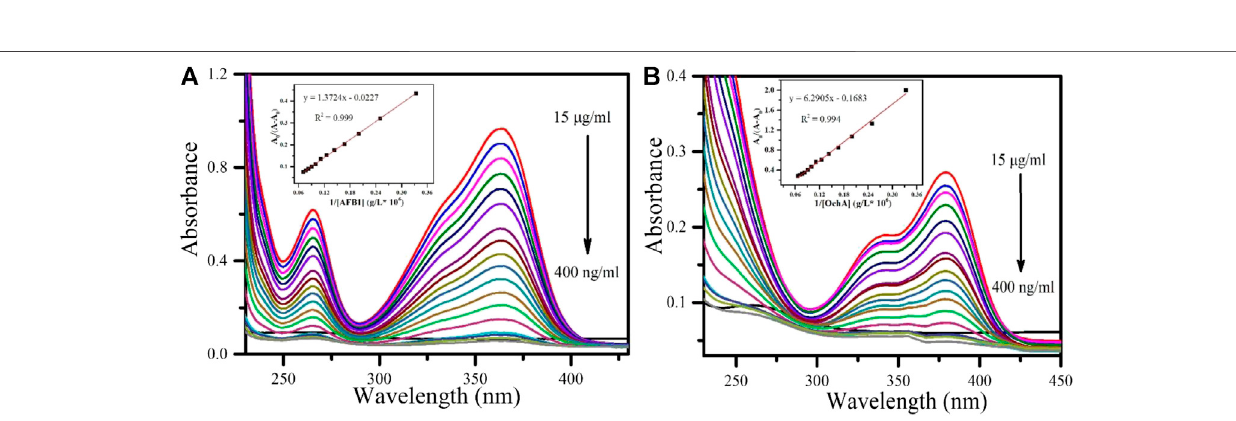
The interaction study was performed using different concentrations of AFB1 and OchA (400 ng ml − 1 – 15 μ g ml − 1 ) at fi xed MnO 2 nps concentrations. The molecular interaction between the chromophore and nucleic acid was observed based on the absorption spectra changes and shifting of